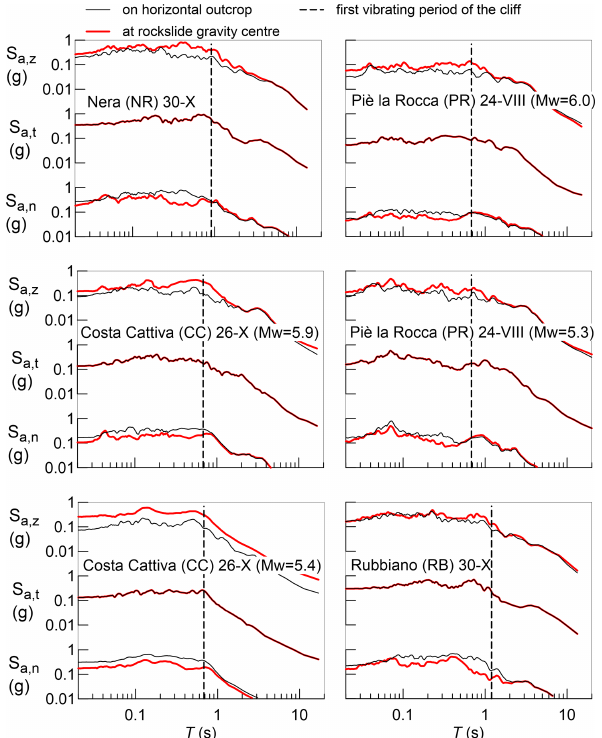
Figure 6. Response spectra of the three components of the acceler- ation at the rigid horizontal outcrop and on the vertical rock cliff at the elevation of the rockslide center of mass as estimated through the seismic response of the numerical model for the four case stud- ies (for each possible triggering earthquake).